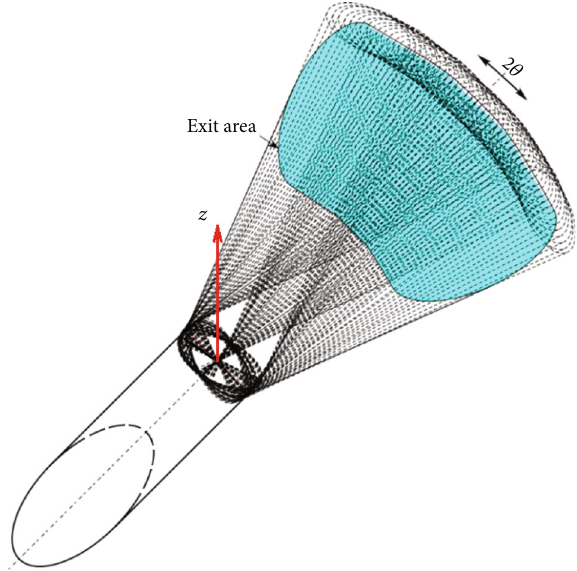
Figure 1: 3d visualization of the proposed di ff usion hole.